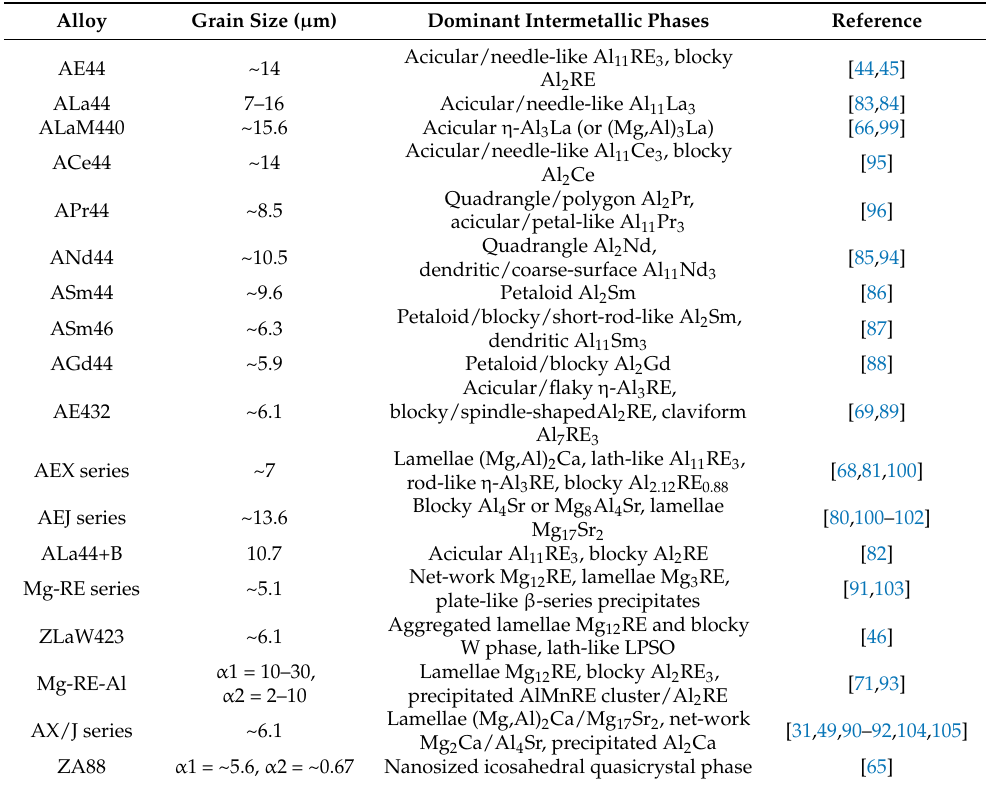
Table 1. Grain size and dominant intermetallic phases in various HPDC Mg